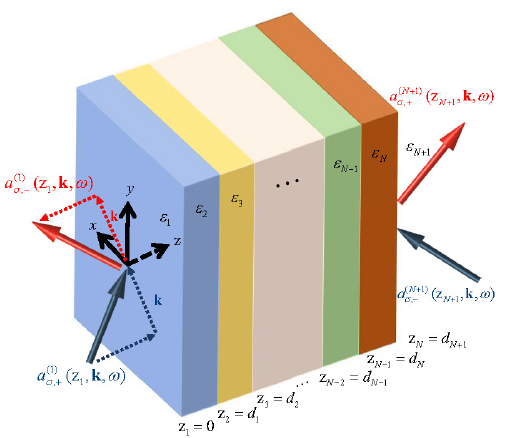
Figure 1. (Color online) Sketch of the planar dielectric medium with permittivity ε j ( ω ) and thick- ness d j of the j th layer. The arrows denote incoming and outgoing fields. Additionally shown are the corresponding annihilation operators used in the definitions of the electric-field operator Equation